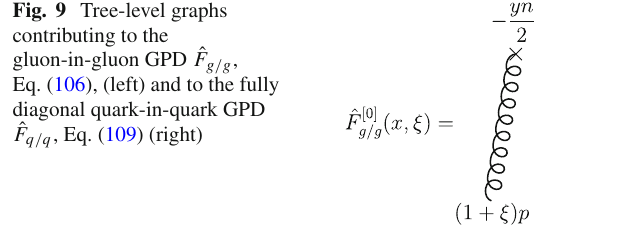
Fig. 9 Tree-level graphs contributing to the gluon-in-gluon GPD ˆ F g / g , Eq. (106), (left) and to the fully diagonal quark-in-quark GPD ˆ F q / q , Eq. (109) (right)